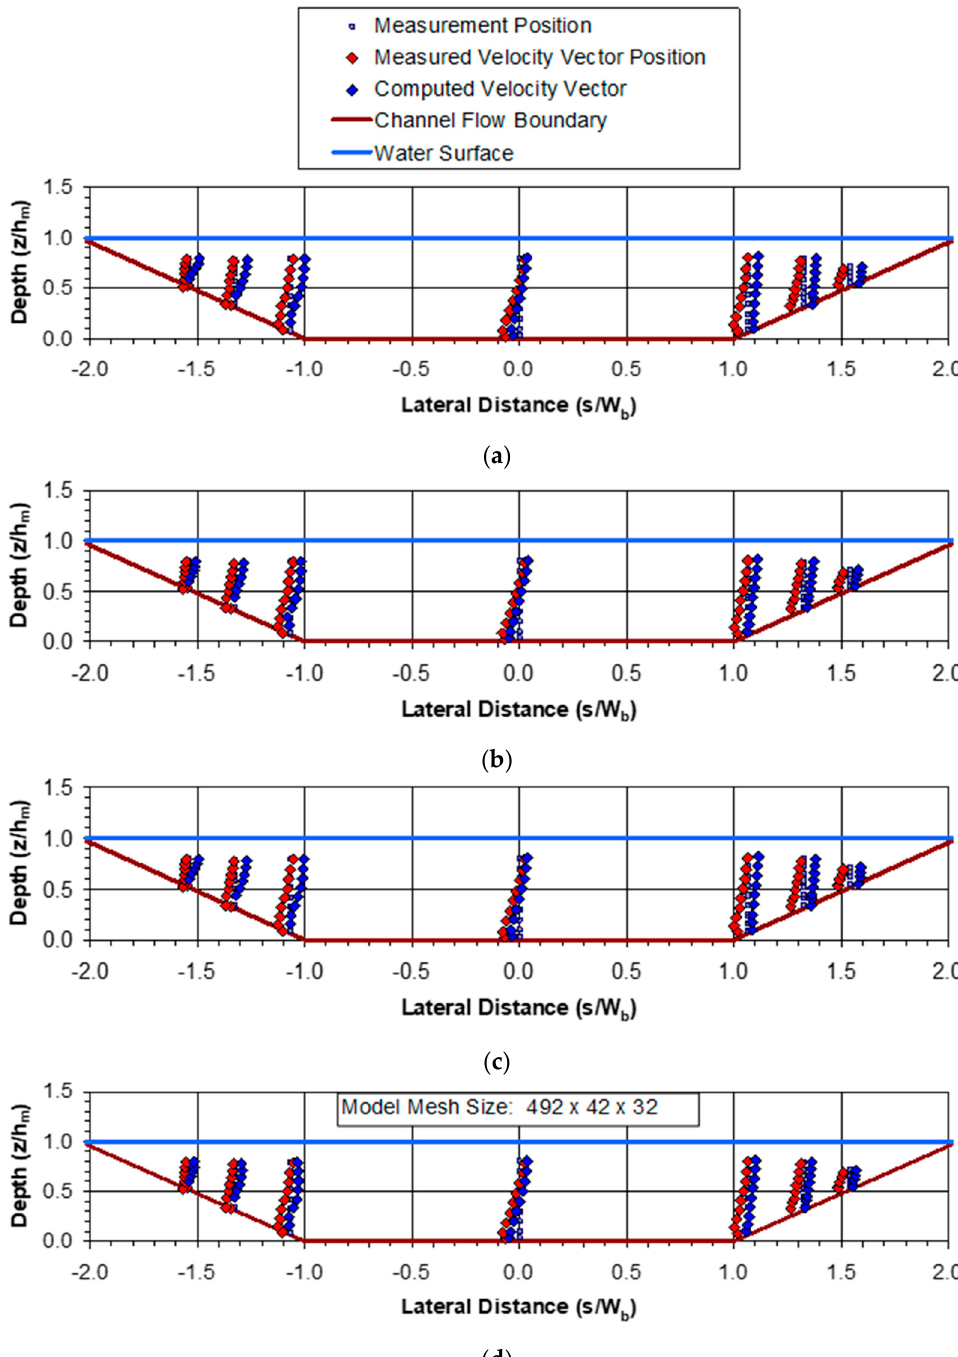
Figure A19. Comparison of simulated and measured cross-stream velocities at Cross-section 16 using four di ff erent 3D mesh sizes. ( a ) 327 × 21 × 16; ( b ) 492 × 21 × 16; ( c ) 492 × 32 × 24; ( d ) 492 × 42 × 32. The simulated velocity results using the two mesh sizes (492 × 32 × 24 and 492 × 42 × 32) are